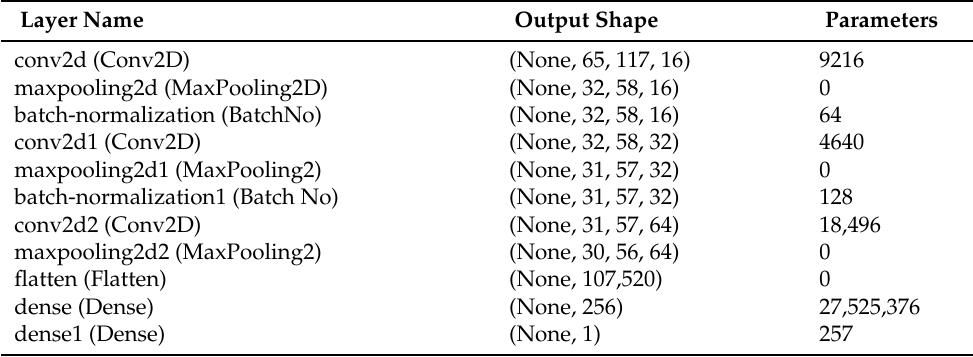
Table 2. Model summary of convolutional neural network designed to extract